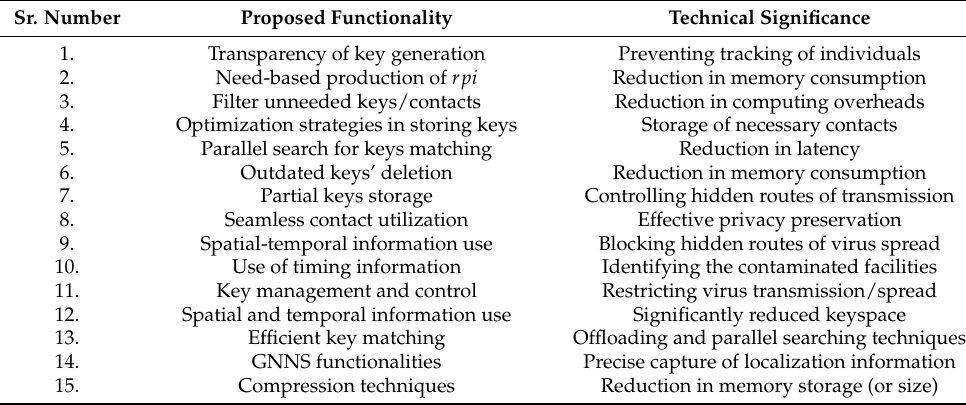
Table 2. In-depth analysis of proposed functionalities for the PPCT. Sr.